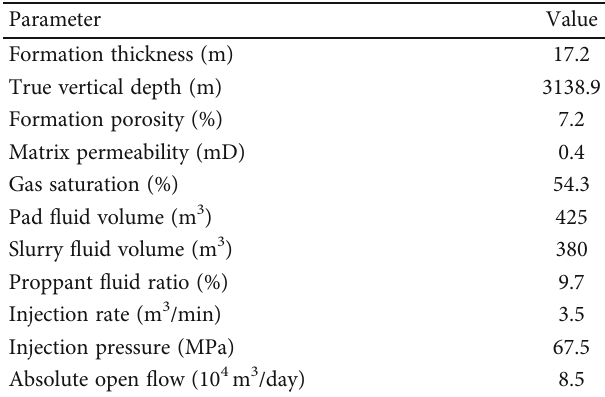
Figure 6: Comparison of actual and predicted AOFP for training and test data.